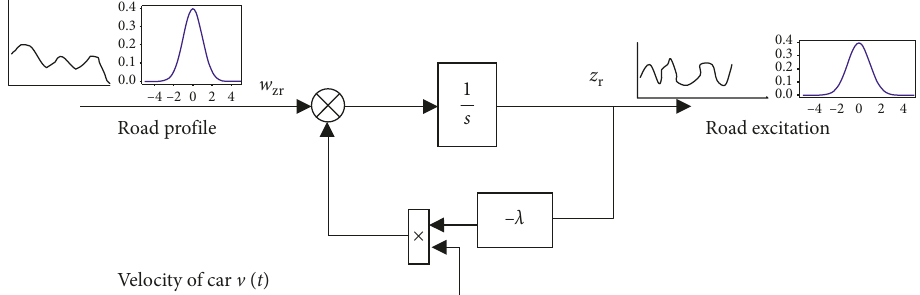
Figure 5: The first-order model of road excitation z